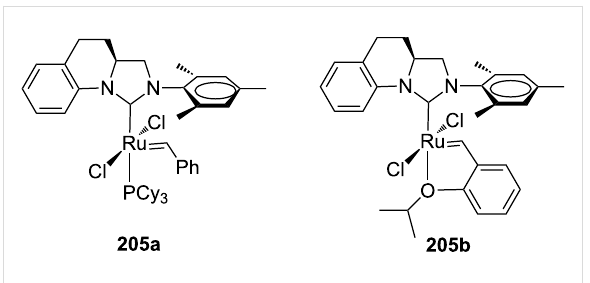
Figure 38: Grubbs ( 205a ) and Hoveyda-type ( 205b ) backbone-mono- substituted